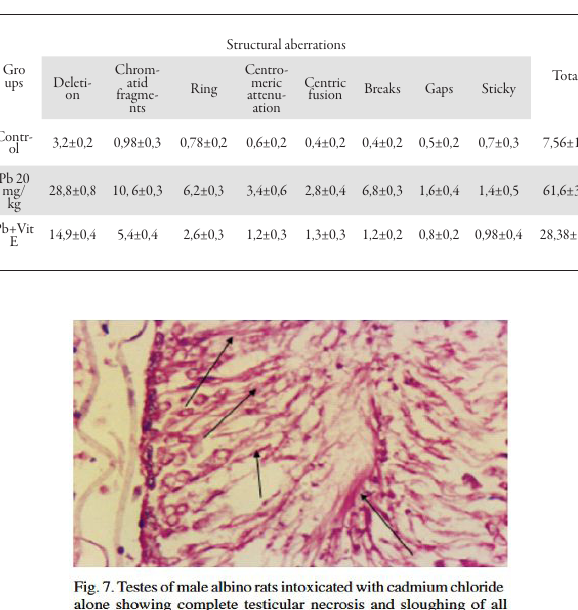
Fig. 4. Testes of male rats control showing normal structure of seminiferous tubules (ST) (H&E X 200) Tab. 4. Average of chromosomal abnor malities observed in bone marrow cells of male rats treated with Pb and protected with Vit E